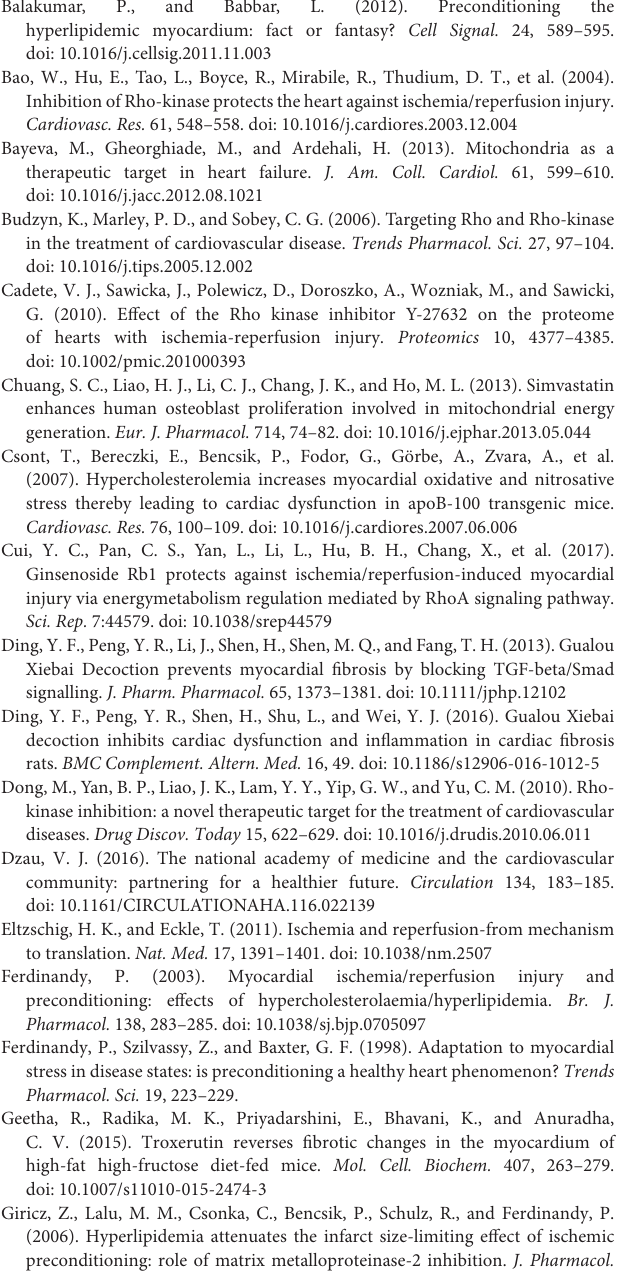
Figure S1 | The full-length representative western blotting bands of ATP5D and GAPDH in different groups as shown with indication of molecular size. The